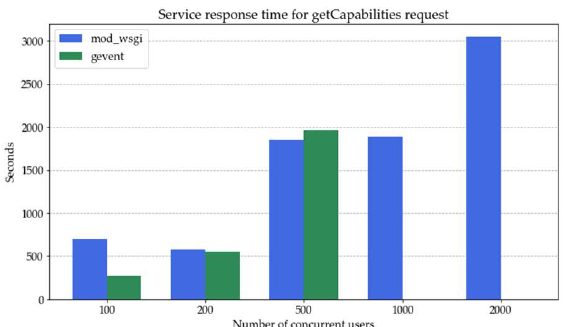
Figure 5. Service response time for the getCapabilities SOS requests in test case C (Springs and Wells Monitoring Network in Ticino) Table 15. Requests per second (total and for different SOS request) with different concurrent data consumers and WSGI applications for the test case of a large size monitoring network (case C). Rate of failure (ρ) is reported when errors have been detected. Values reported as n.a. indicates that it was not possible to execute the test for that request and users combination.